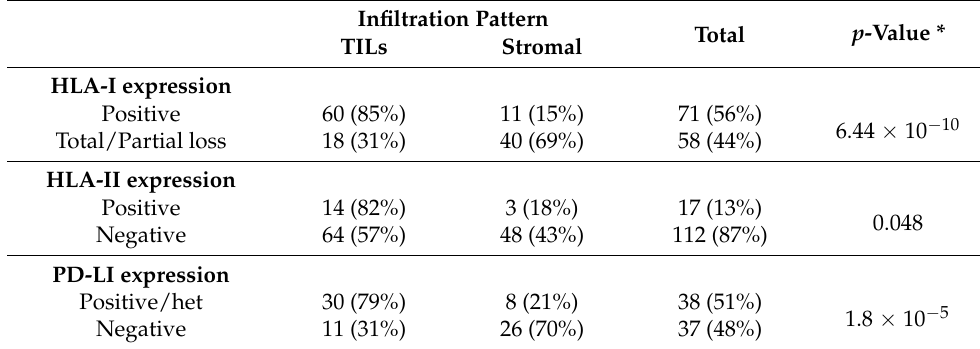
Table 4. Correlation between HLA-I, HLA-II, PD-L1 expression and T-cell infiltration patterns.